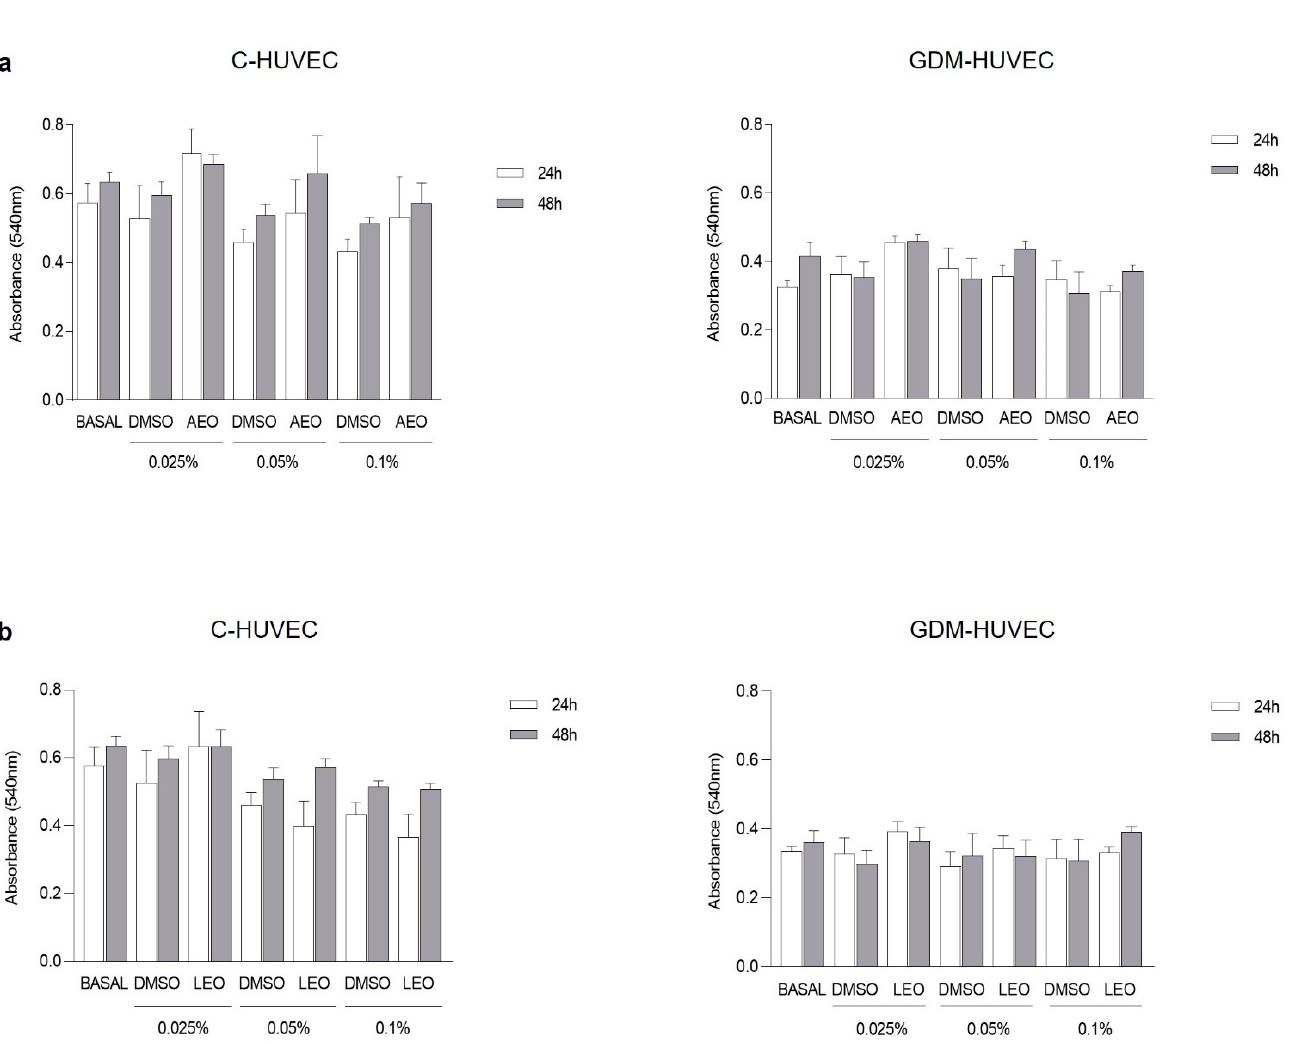
Figure 1. C- and GDM-HUVEC cell viability after 24 h and 48 h of treatment with ( a ) AEO and ( b ) LEO at different concentrations (0.025, 0.05, and 0.1% v / v ) or with medium alone (BASAL). Results are shown as mean ± Standard Error of the Mean (SEM). All experiments were conducted in technical and biological triplicate using at least 3 different primary culture strains of C- and GDM-HUVEC. Similarly, the treatment with the same concentration of LEO for 24 h significantly decreased U937 cell adhesion to TNF- α stimulated C- and GDM-HUVEC (Figure